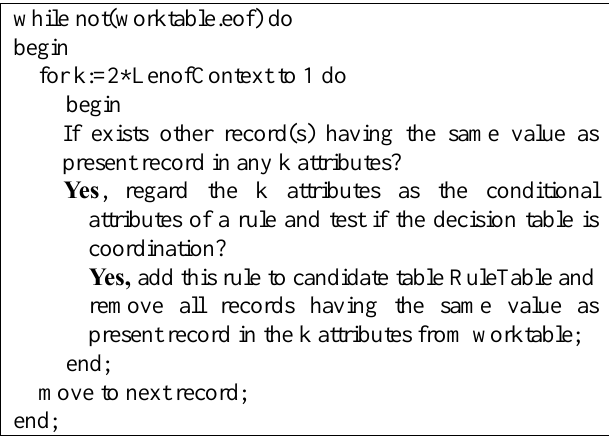
Figure 2. Pseudocode of ProduceFromLtoS